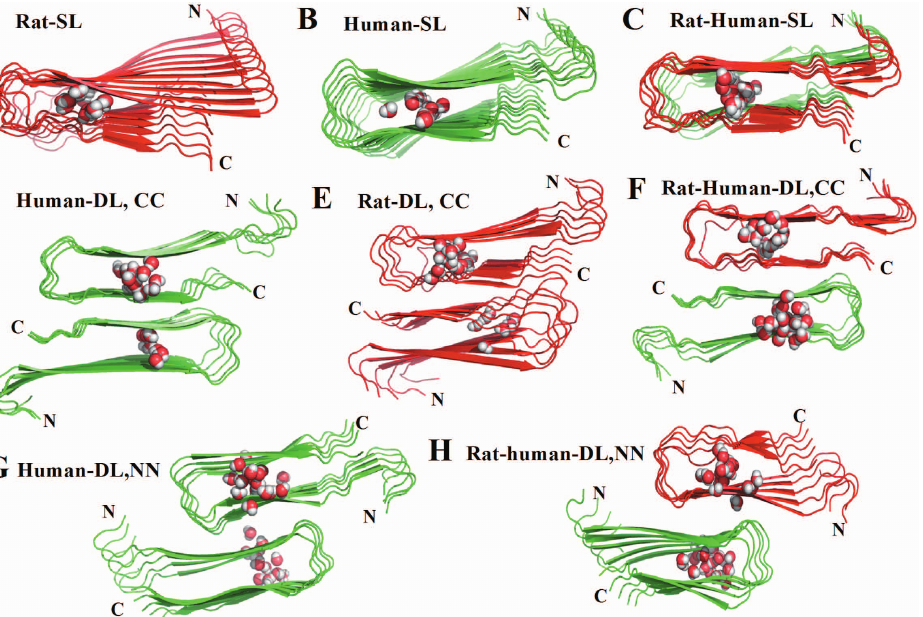
Figure 5. Representative snapshot of water molecules in the amylin single layer, double layer, and the complexes between human and rat amylin model. (A) Single layer conformation of human amylin, (B) single layer conformation of rat amylin, (C) single layer conformation of human-rat complex, (D) Double layer conformation of human amylin with CC interface (E) Double layer conformation of rat amylin with CC interface, (F) Double layer conformation of rat and human amylin mixtures with CC interface, (G) Double layer conformation of rat amylin with NN interface and (H) Double layer conformation of rat–human amylin complex with NN interface. Different colors mark rat (red) and human amylin (green).